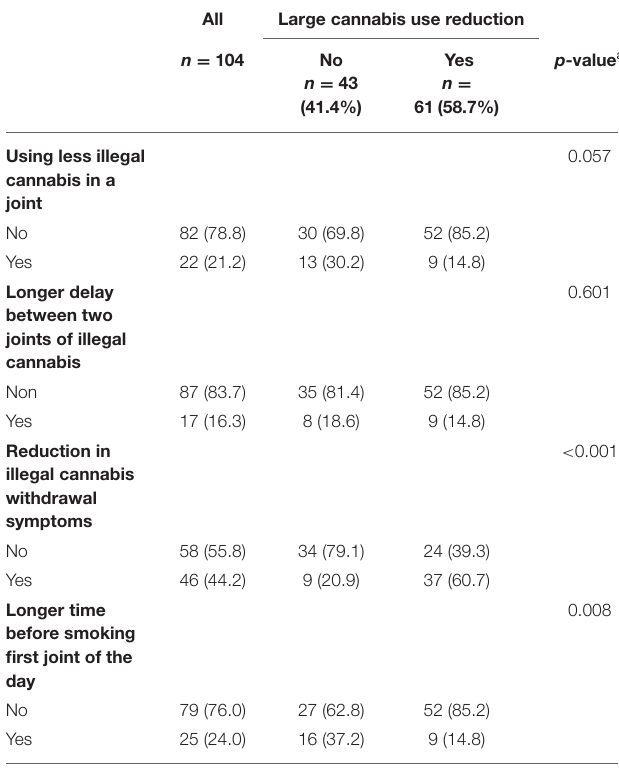
TABLE 3 | Self-reported CBD-related effects at play in cannabis use